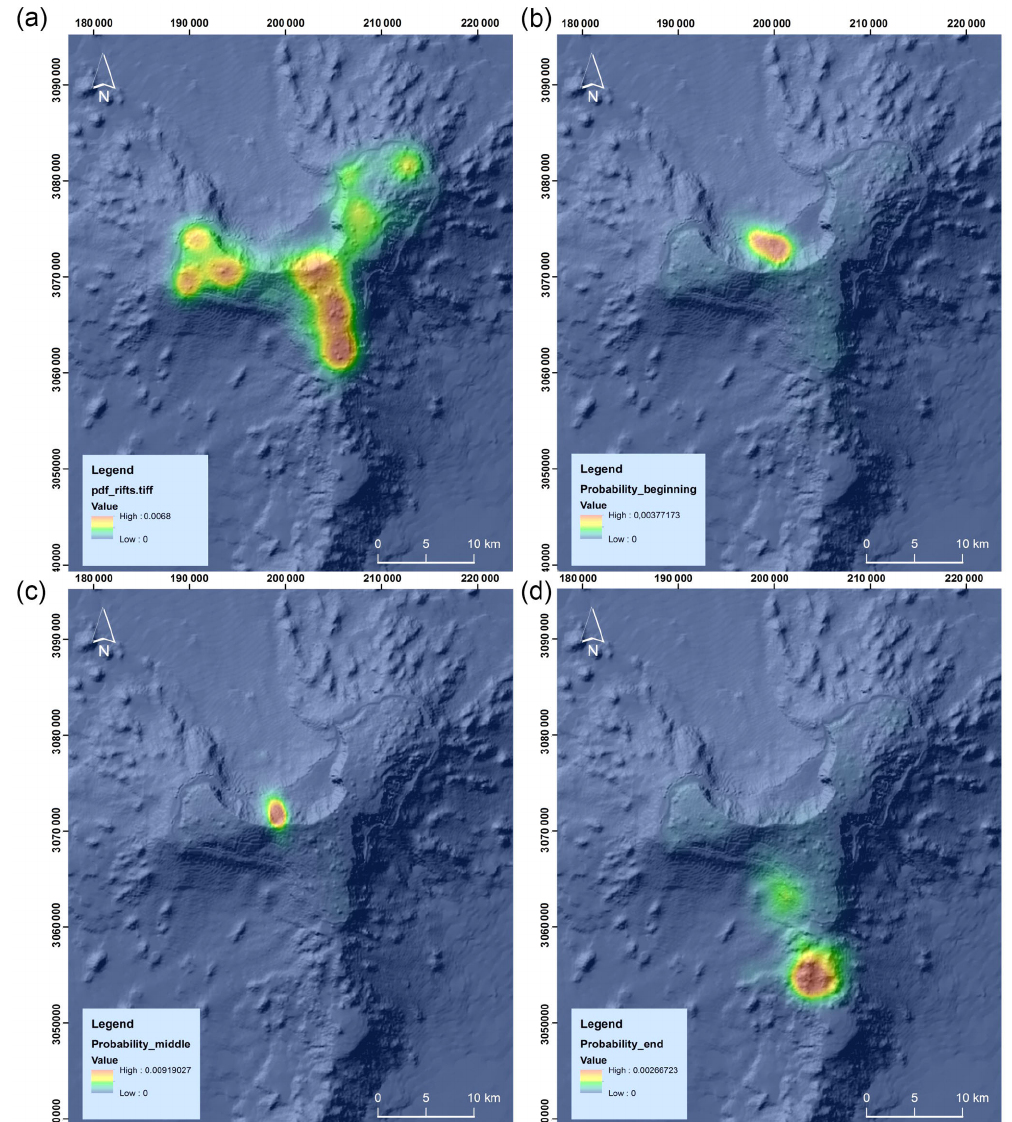
Figure 3. Susceptibility maps obtained from (a) the volcano-structural data; (b) the first days of unrest; (c) the middle of the unrest; (d) the days before the submarine